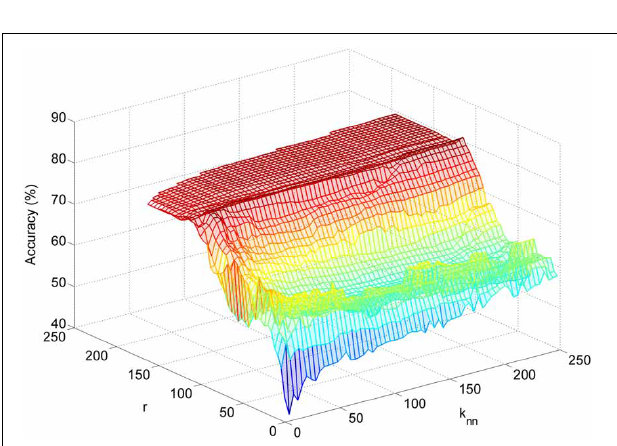
indicating similar, less prominent RPs for both the triggered and self-initiated trials. For each subject, MRPs were averaged across all 20 movements for each condition; movement onset is at 0s.